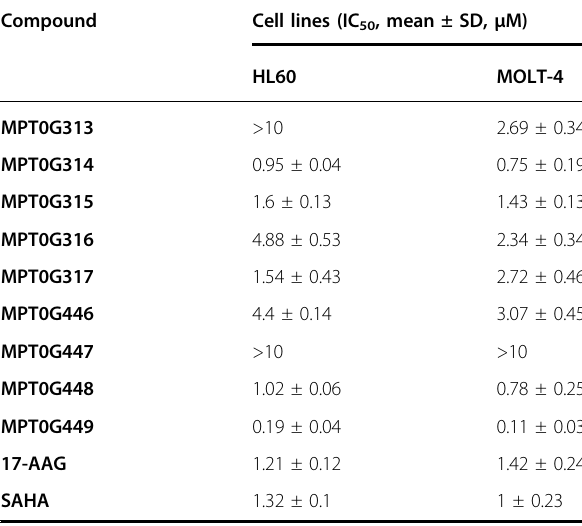
Table 1 The cytotoxic effect of dual HDAC and HSP90 inhibitors in acute leukemia